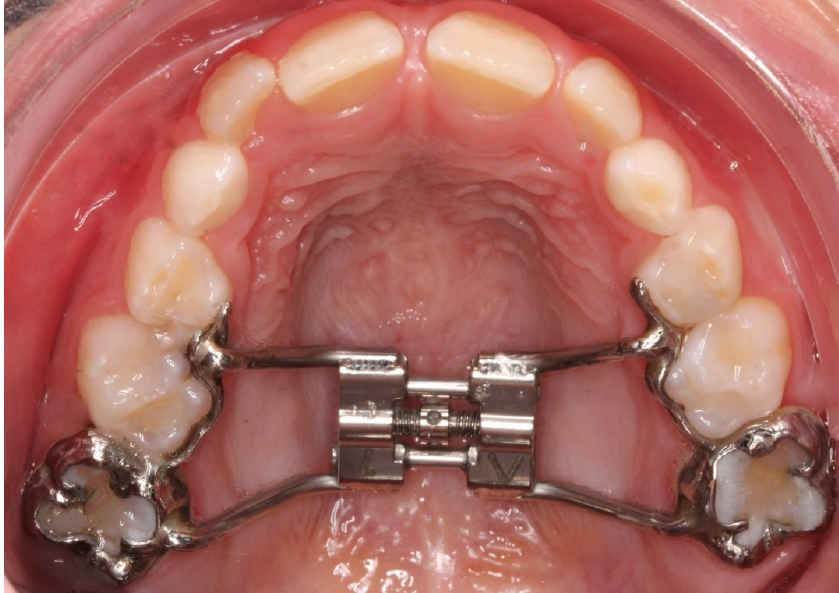
Figure 6. An RPE designed in Meshmixer and printed in CoCr. The screw is soldered to the customized bands on a printed dental model.